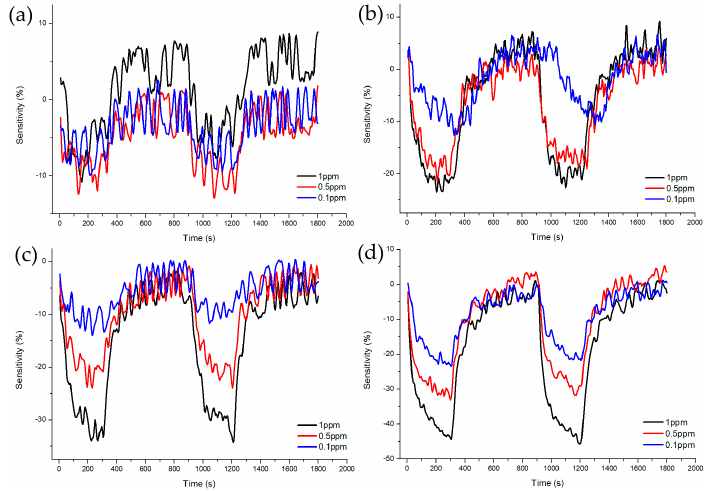
Figure 8. Characteristics of sensitivity and recovery rate of ZnO-TiO2 gas sensor for lower concentration (1~0.1 ppm) formaldehyde gas. ( a ) ZnO(90%)-TiO 2 (10%) ( b ) ZnO(95%)-TiO 2 (5%) ( c )